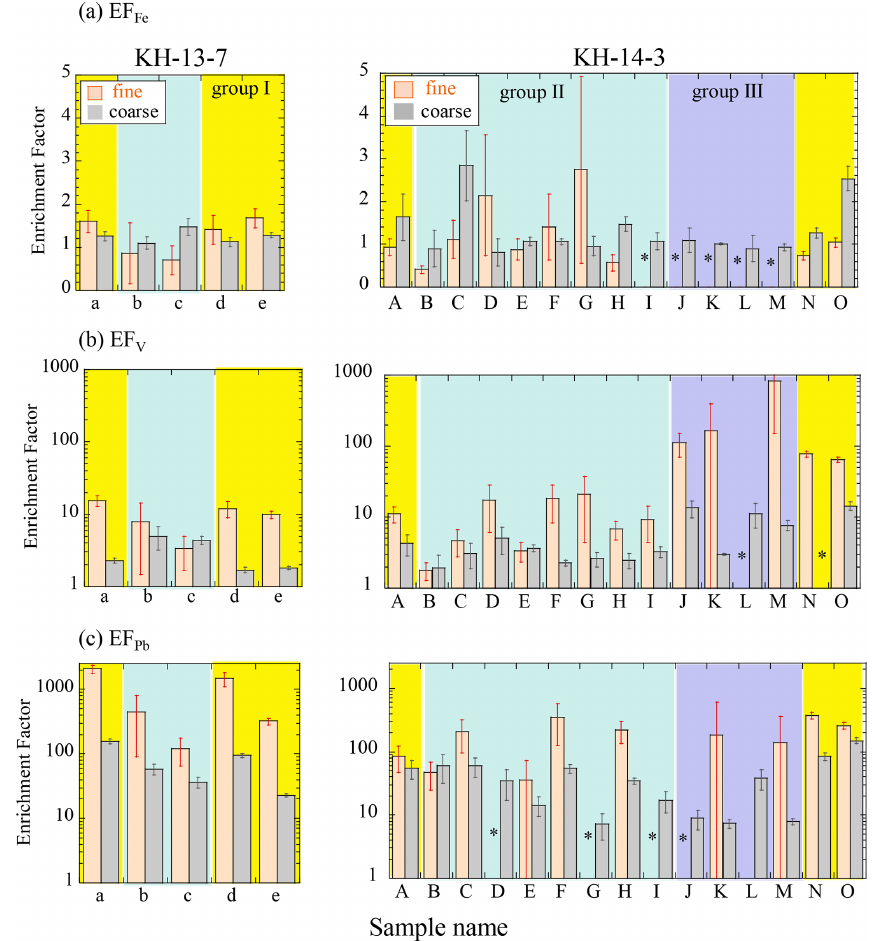
Figure 4. Enrichment factors of (a) Fe, (b) V, and (c) Pb. Errors were calculated from ICP-MS error and blank subtraction errors. Yellow, blue, and purple areas indicate groups I (air masses from the direction of East Asia), II (air masses from the central and eastern Pacific), and III (air masses from the northern North Pacific), respectively. ∗ Not available due to insufficient sample